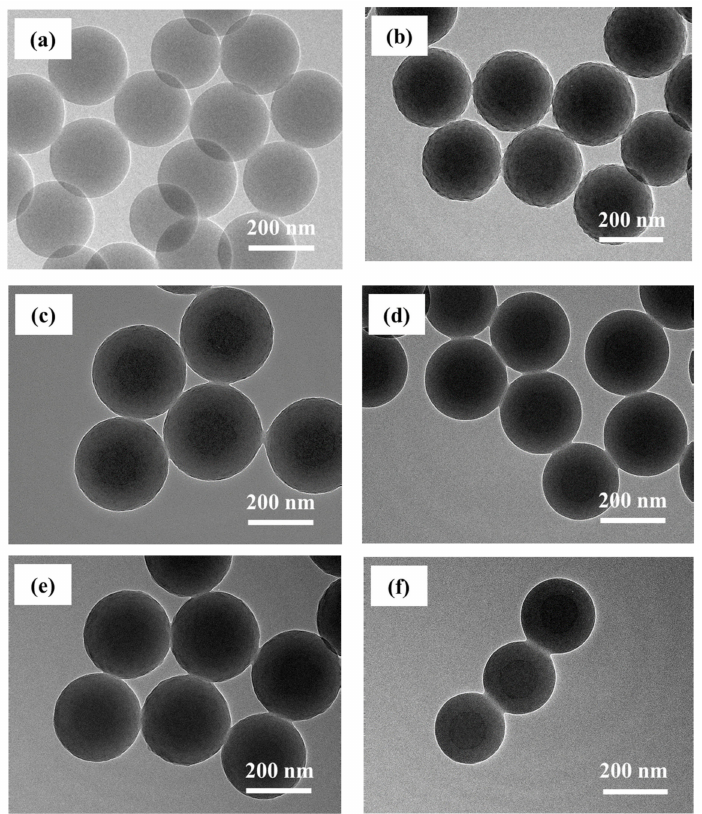
Figure 4. TEM images of PSt-based microspheres; ( a ) PSt, ( b ) P(St-AA), ( c ) P(St-MMA-AA), ( d ) P(St- MMA), ( e ) P(St-BA-AA), and ( f )